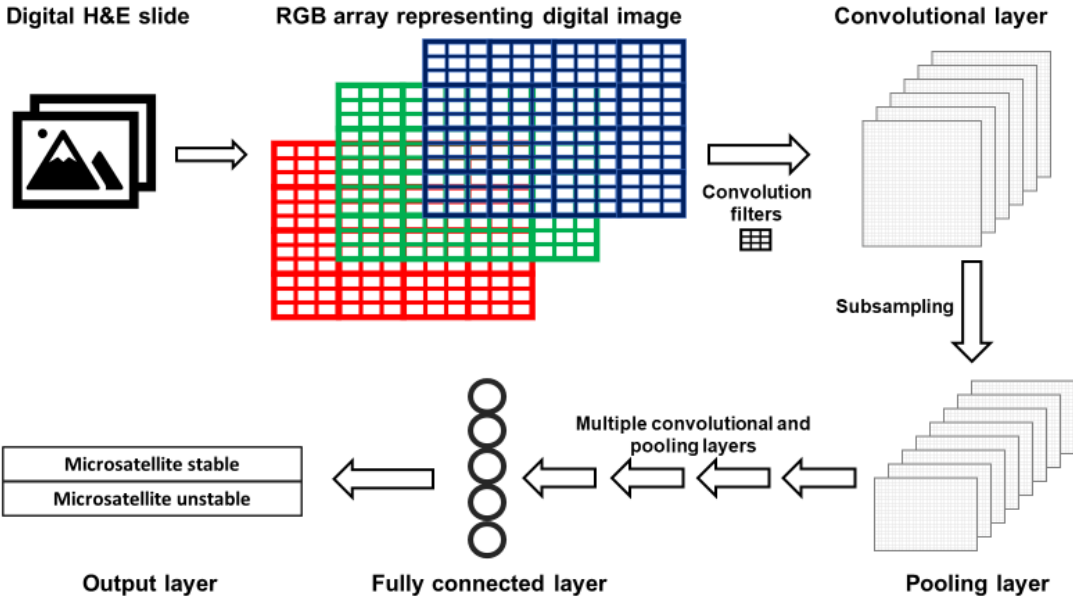
Figure 2. Simplified architecture of a convolutional neural network (CNN). Images acquired with digital pathology are composed of pixels. The color of each pixel can be represented with values of the red, green and blue (RGB) scheme. RGB arrays are subjected to filters to create a convolutional layer. Filters detect specific features from an image (e.g., lines, edges). A pooling layer with a reduced number of parameters is created by summarizing (subsampling) the input of the convolutional layer. After a defined number of convolutional and pooling layers, fully connected layers are created. Fully connected layers are uni-dimensional layers from which the output is predicted.